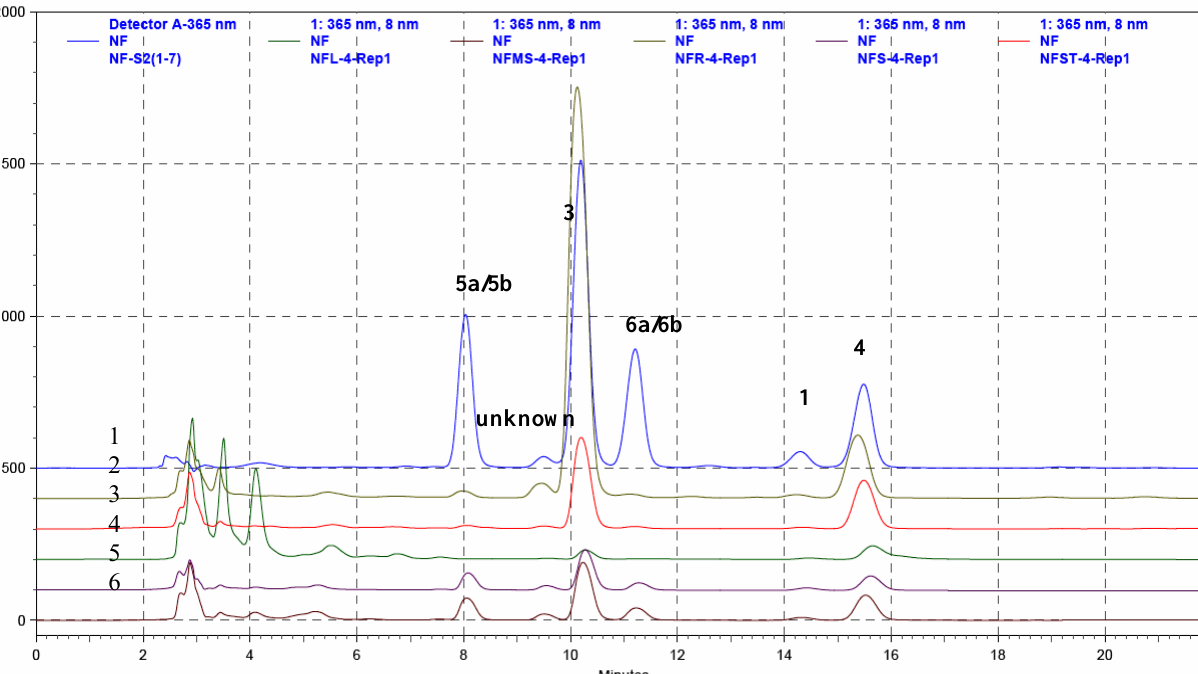
Figure 2B . The HPLC profiles of different parts of crude extracts from the top to bottom are: 1. mixture of compounds 1, 3 , 4 , 5a / 5b and 6a / 6b ; 2. roots; 3. stems; 4. leaves; 5. immature seeds; and 6. mature seeds.